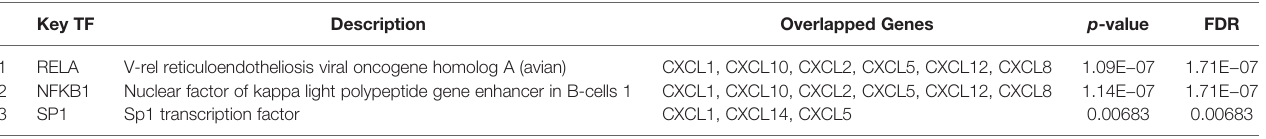
TABLE 4 | Key regulated factor of abnormal expression CXC chemokines in PAAD